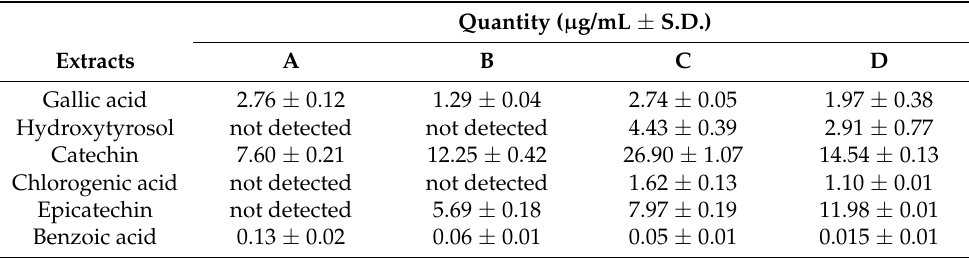
Table 1. Quantitative analysis of phenolic and flavonoid compounds in P. columbinus